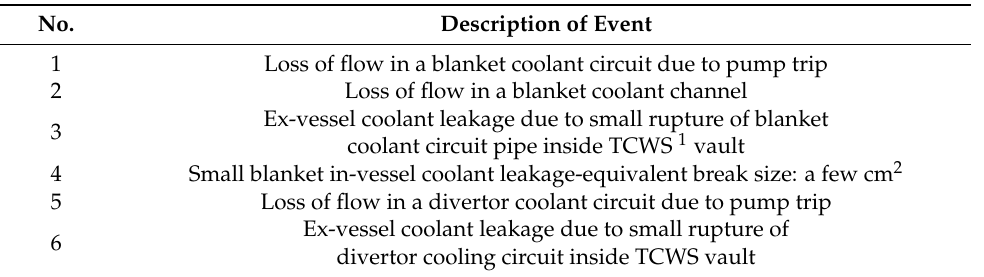
Table 2. Events in Category II for the blanket and divertor